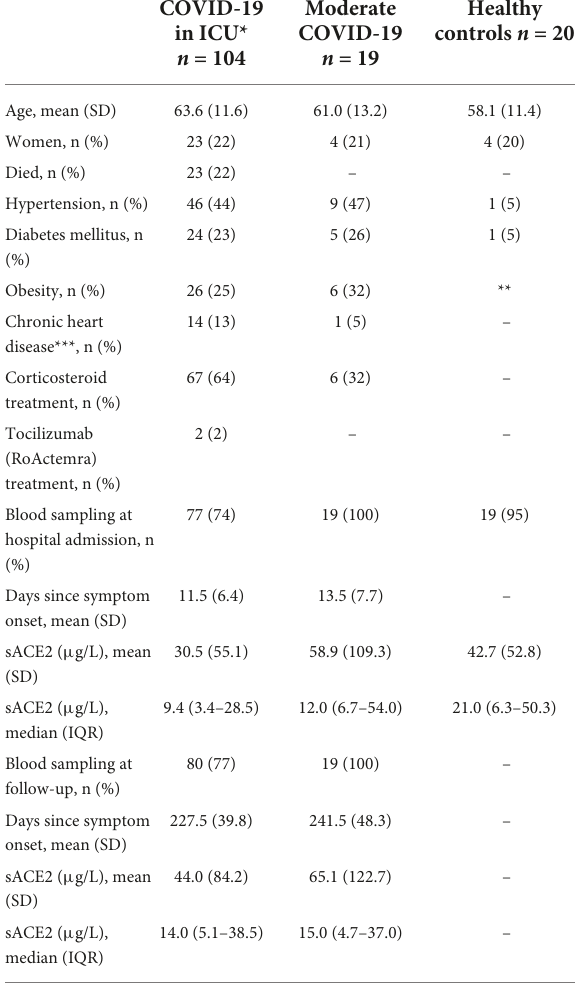
TABLE 1 Descriptive statistics of included COVID-19 patients and healthy